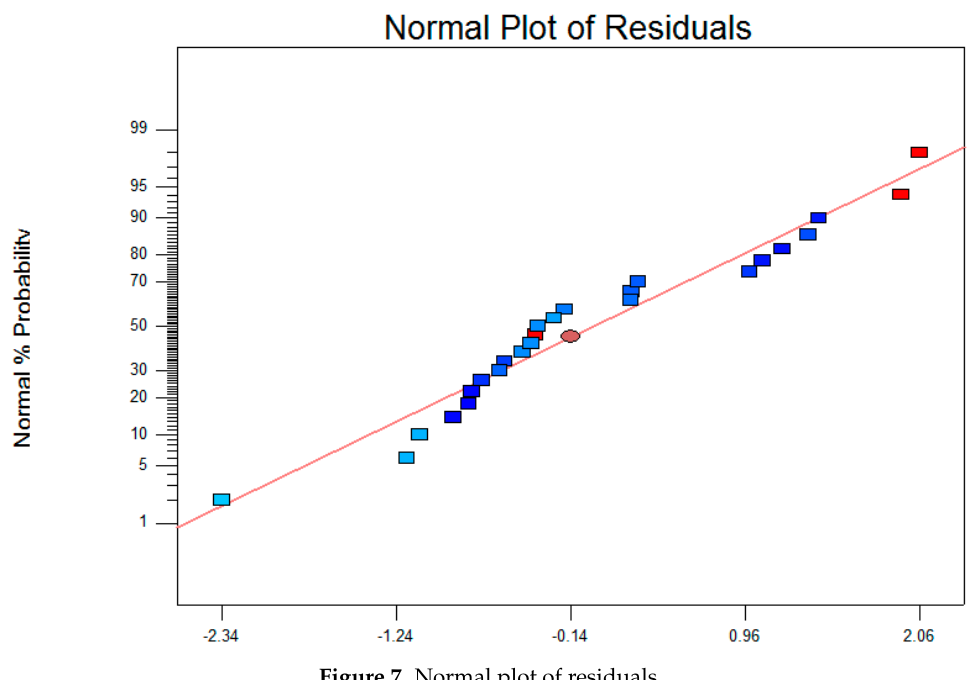
Figure 7. Normal plot of residuals.